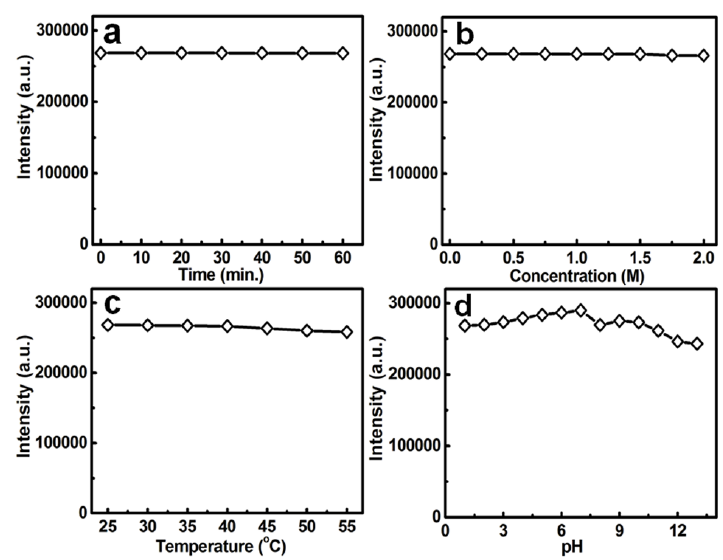
Figure 6. PL intensity variation of the CQDs-120 as a function of ( a ) illumination time of UV lamp with the center wavelength at 365 nm, ( b ) NaCl concentration, ( c ) temperatures, and ( d ) pH values (λ ex = 380 nm).